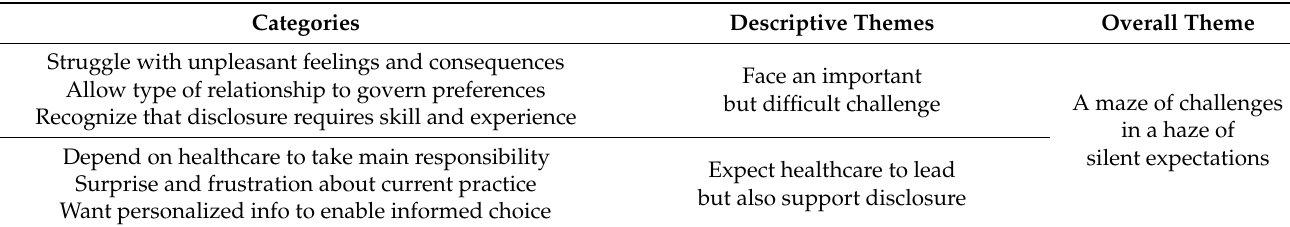
Table 3. Categories and themes derived from the qualitative content analysis of focus group data.